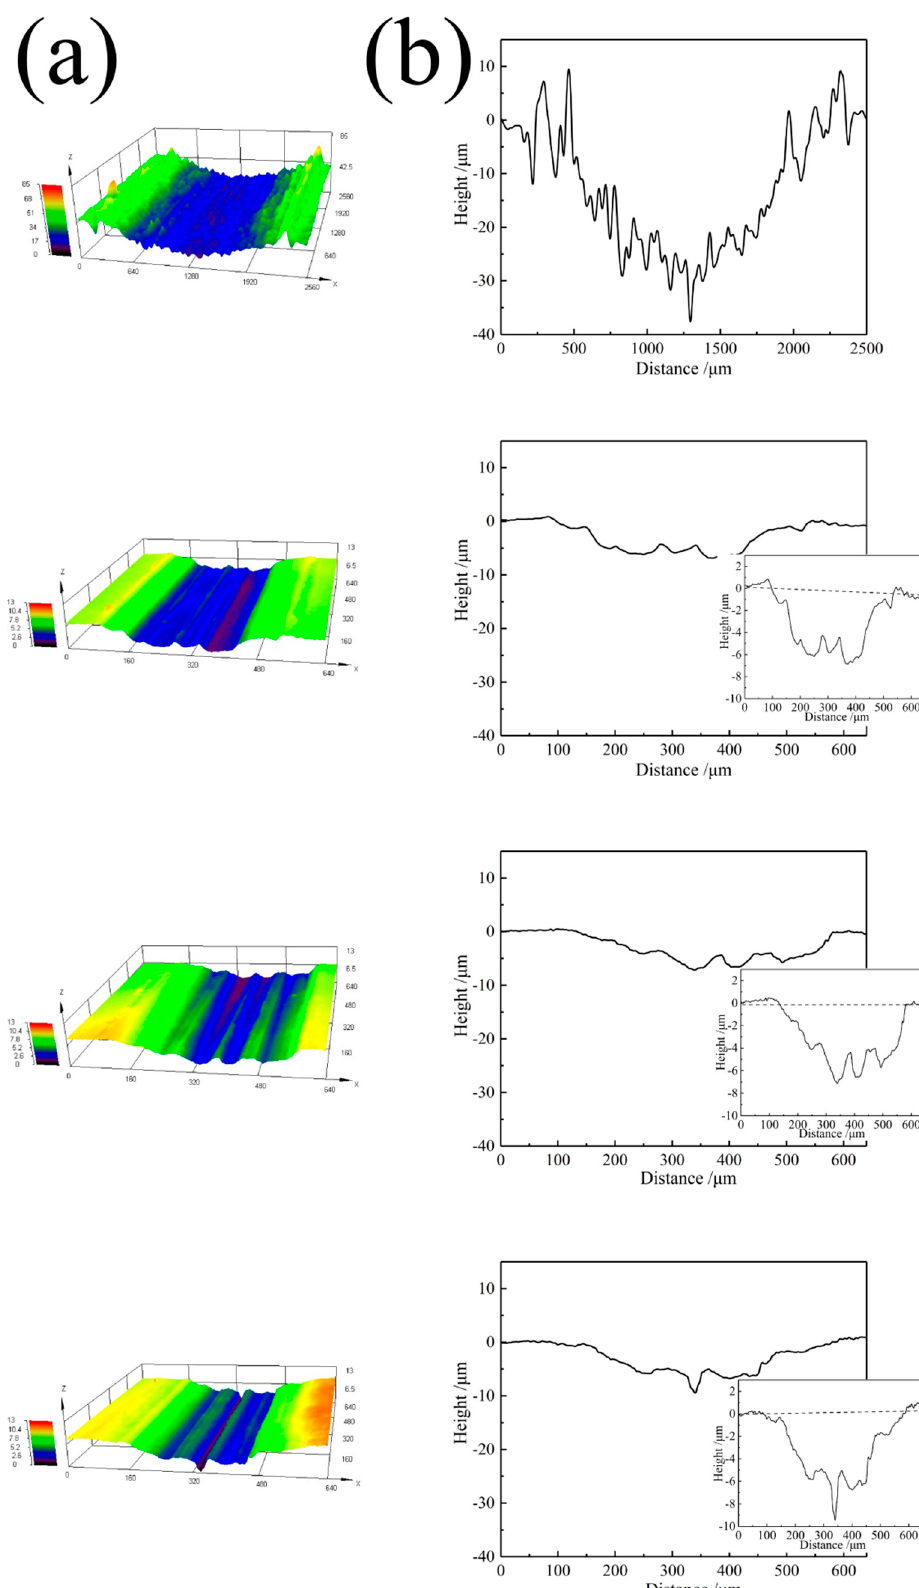
Figure 13. 3D morphology ( a ) and wear profiles ( b ) of the substrate and cladding coatings.